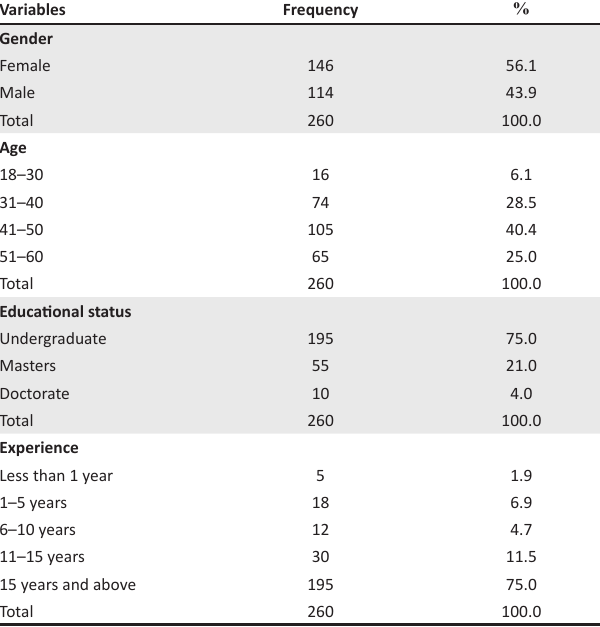
TABLE 1: Demographic profile of respondents. Variables